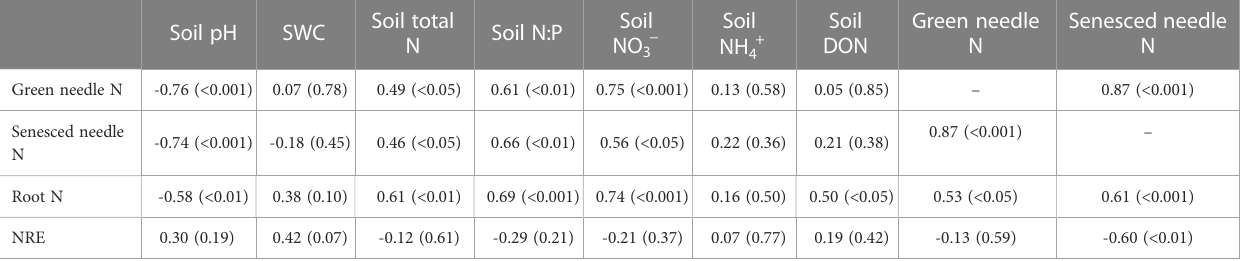
TABLE 3 Pearson correlations between nitrogen resorption ef fi ciency (NRE) and N content in plant and soil.